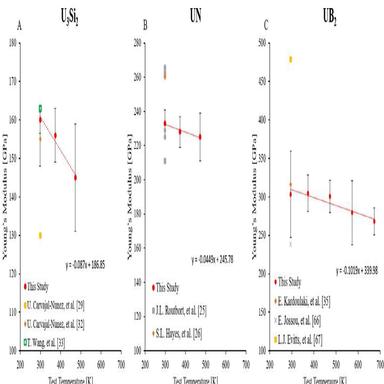
The Young's modulus of the advanced ATF over temperature as measured using nanoindentation. At each test temperature on each sample a minimum of 16 indents was performed with a 20 μm spacing. (A) U3Si2, (B) UN, and (C) UB2.